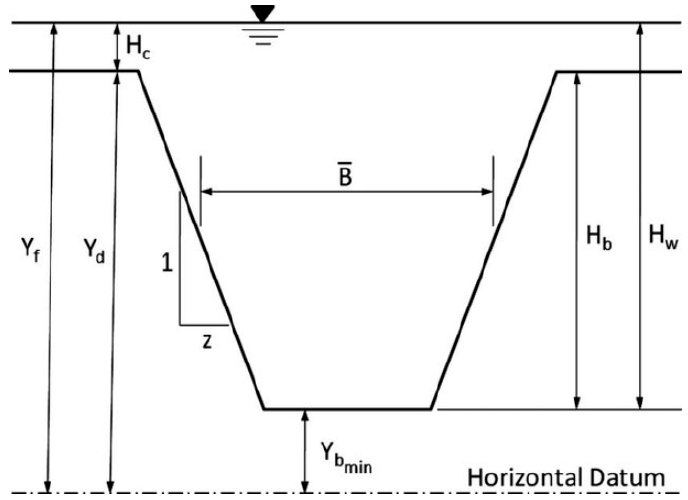
Figure 3. Dimensions of a trapezoidal dam breach approximation (Froehlich,